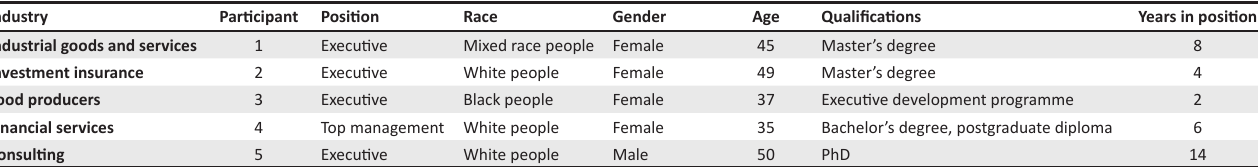
Table 3: Participant biographic data. Industry